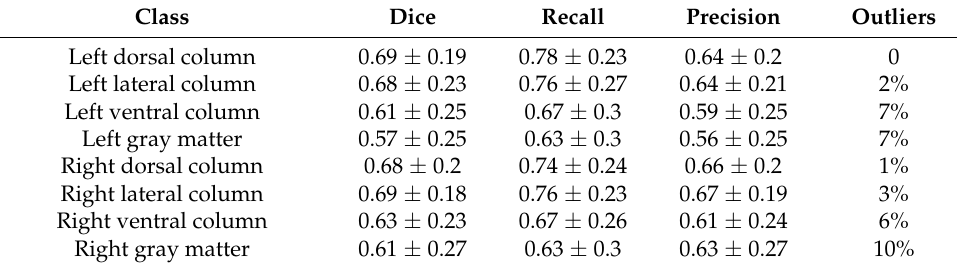
Table 2. The performance of UNet with proposed loss removed outlier slices.